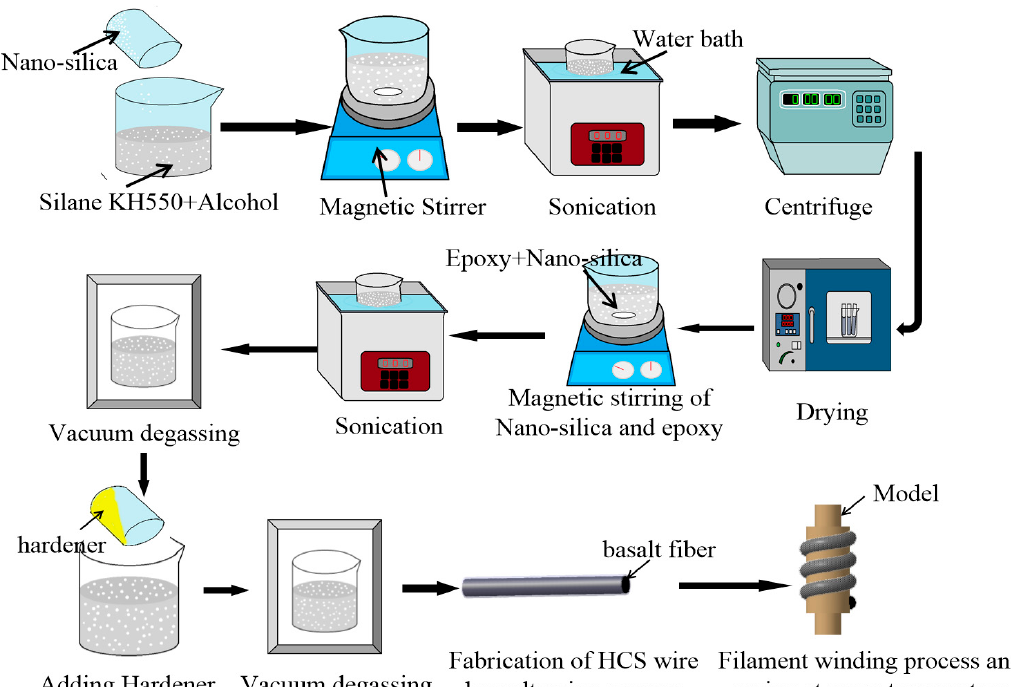
Figure 2. Process chart for preparing basalt fiber/epoxy helical composite spring.